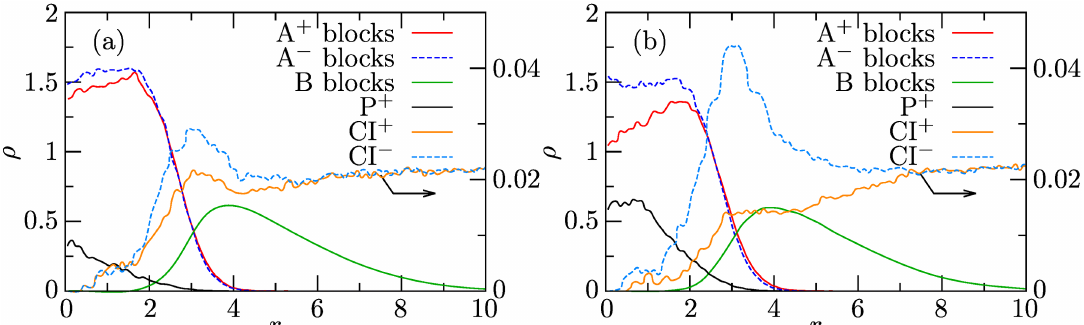
Figure 7. Radial density profiles, ρ , of the associates from the system with 10 P + composed of 15 PE + and 15 PE − with ( a ) 1 P + or ( b ) 3 P + solubilized in its IPEC core.